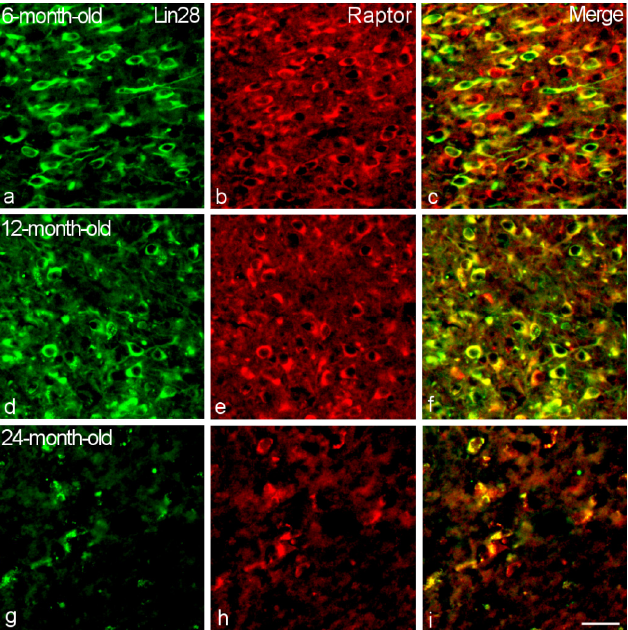
Figure 7. Colocalization of Lin28 with Raptor in the VMH neurons of 6-month-old ( a – c ), 12-month- old ( d – f ) and 24-month-old ( g – i ) male rats. Double labeling of Lin28 ( a , d , g , green, left panel), Raptor ( b , e , h , red, middle) and composite image ( c , f , i , right). Bar, 25 µm.